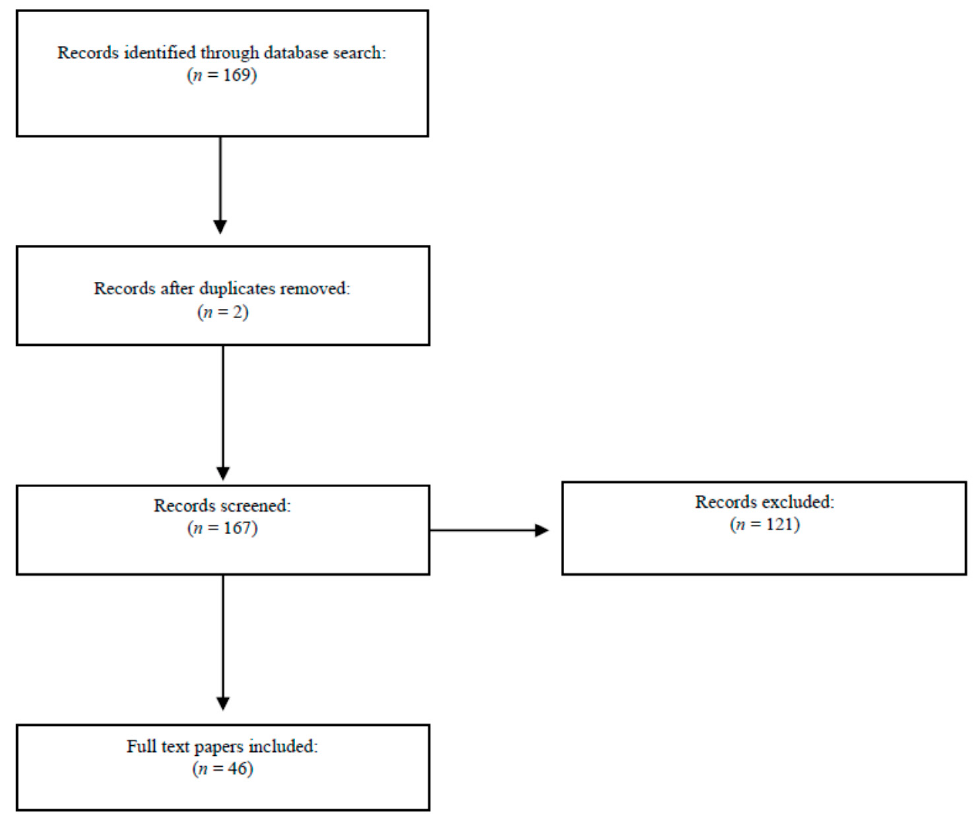
Figure 4. Flowchart depicting the choice of